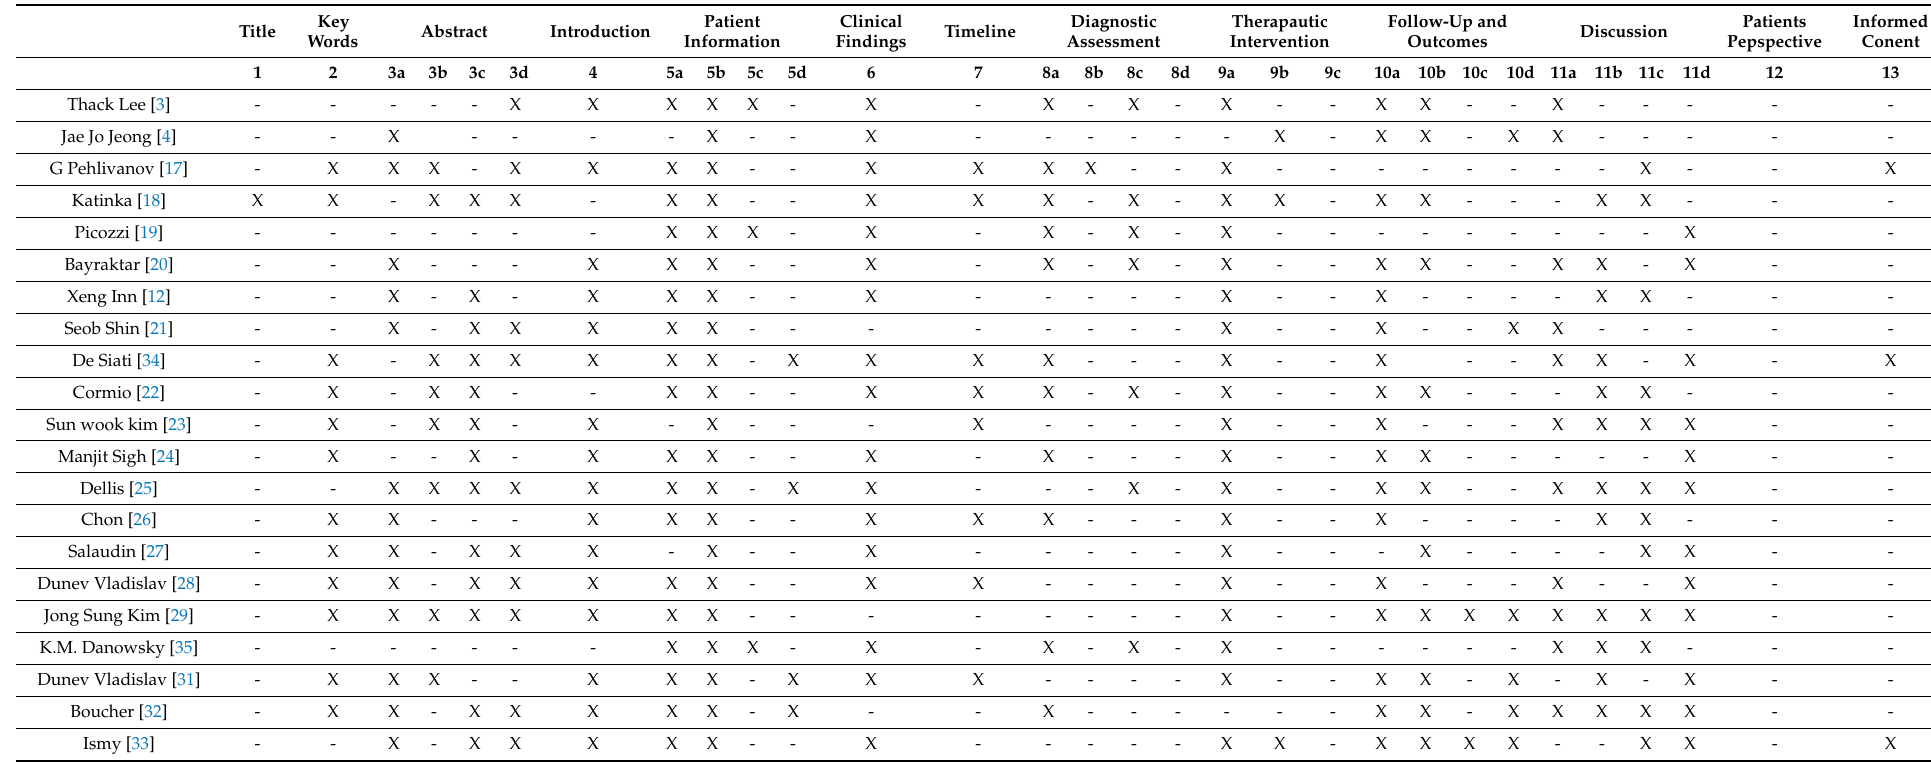
Table 2. CARE checklist